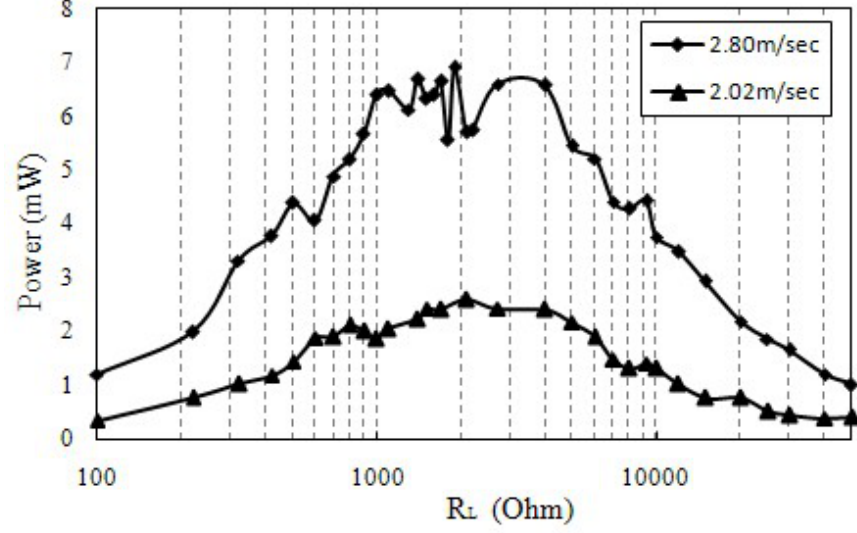
Figure 11. Experimental output power vs. load resistance under two wind speeds. = 0.5 cm, attack angle α (amplitude h 0 = 20° when U = 2.8 attack angle α 0